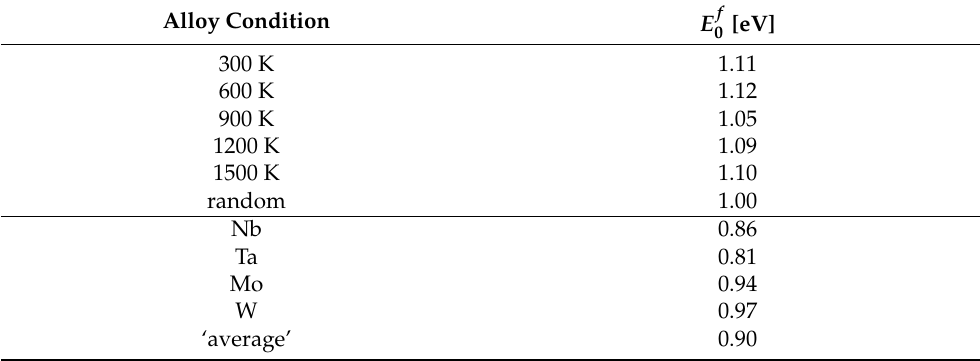
Table 6. Statistical averages of vacancy formation energy distributions of position ’0’ in alloys with varying degrees of short range order. The ’average’ represents the weighted average of vacancy formation energies at position ’0’ in Nb, Ta, Mo, and